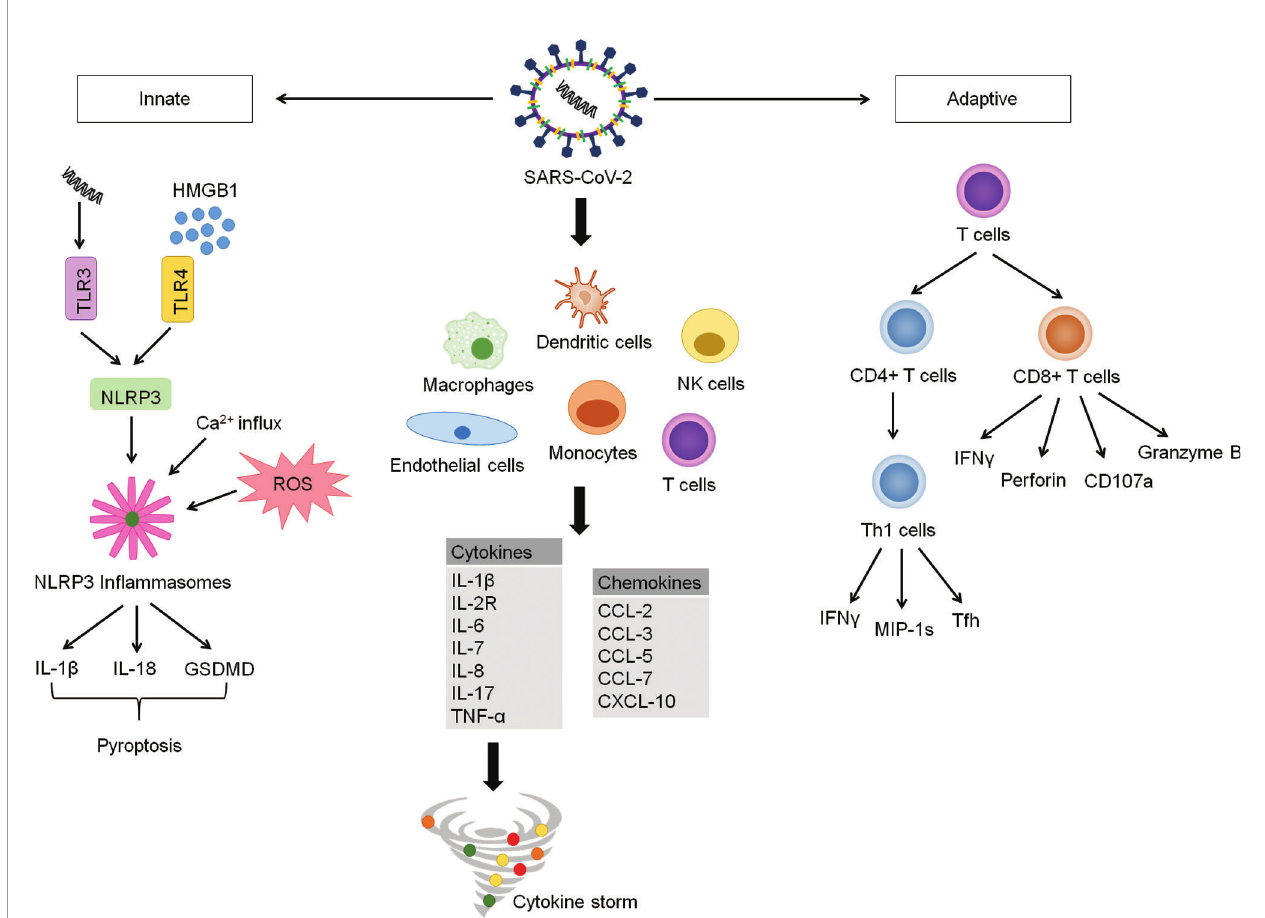
FIGURE 1 | COVID-19 In fl ammatory Signaling Pathway. COVID-19 is characterized by delayed intracellular innate immune responses associated with type I and type III IFNs. This allows for rapid virus replication and subsequent PRR-induced abnormal in fl ammatory response. SARS-CoV-2 invade and activate of various immune cells such as endothelial cells, macrophages, monocytes, dendritic cells, natural killer cells and T-cells. These abnormally activated immune cells stimulate multiple in fl ammatory pathways producing large amounts of cytokines and chemokines, which results in hyperin fl ammation and cytokine storm. The formation of cytokine storm reduces further spread of virus in the body but also causes tissues damage, causing acute respiratory distress syndrome (ARDS) and multi-organ failure. Upon entering cells, SARS-COV-2 is recognized by pattern-recognition receptor (toll-like receptor 3), resulting in activation of NLRP3. Simultaneously, the viral invasion causes protein aggregation, calcium in fl ux and ROS formation. These events lead to the initiation of NLRP3 in fl ammasome. Activated NLRP3 in fl ammasome stimulates activation of caspase-1, which cleaves Gasdermin D (GSDMD), resulting in pyroptosis of cells. Activated caspase-1 also promotes the secretion of IL-1 b , IL-18, which play an important role in pyroptosis procession. HMGB1, a prototypical DAMP activates in fl ammasome and play an essential role in the in fl ammatory response in COVID-19 patients. The adaptive immunity kicks off soon after the trigger of innate immune response to control virus infection through antibody- producing B cells, CD4+ T cells and CD8+ T cells. CD4+ T cells are important for virus clearance, while CD8+ T cells provide protection against the virus through multiple cytokines. However, CD4+ and CD8+T cells are found to be signi fi cantly reduced in patients with severe